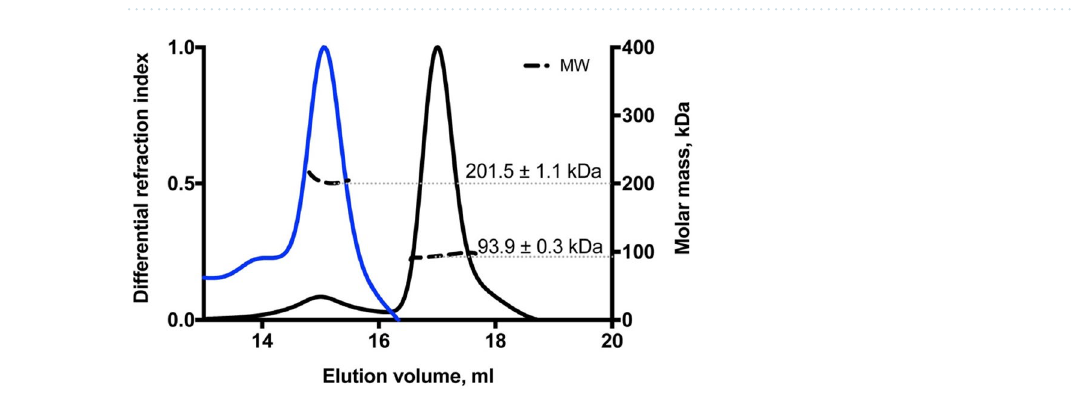
Figure 4. ( a ) SEC chromatographs of samples of active MbxA (dashed line) and proMbxA (solid line), respectively, applied to a Superose 6 Increase 6/30 column (GE Healthcare). The absorbance at 280 nm of the elution profile of proMbxA was plotted on the left Y axis, the elution profile of active MbxA on the right Y axis. proMbxA eluted in two separate main peaks, marked 1 and 2 in the chromatogram. ( b ) CBB stained SDS PAGE gels of pooled fractions of active MbxA and proMbxA obtained from IMAC purification (left panel) and used for SEC. The entire gels are shown in Figure S9. proMbxA was separated in two species, peak 1 and peak 2, during SEC and evaluated by SDS PAGE (right panel). Molecular weight markers in kDa are shown in lanes I and II.